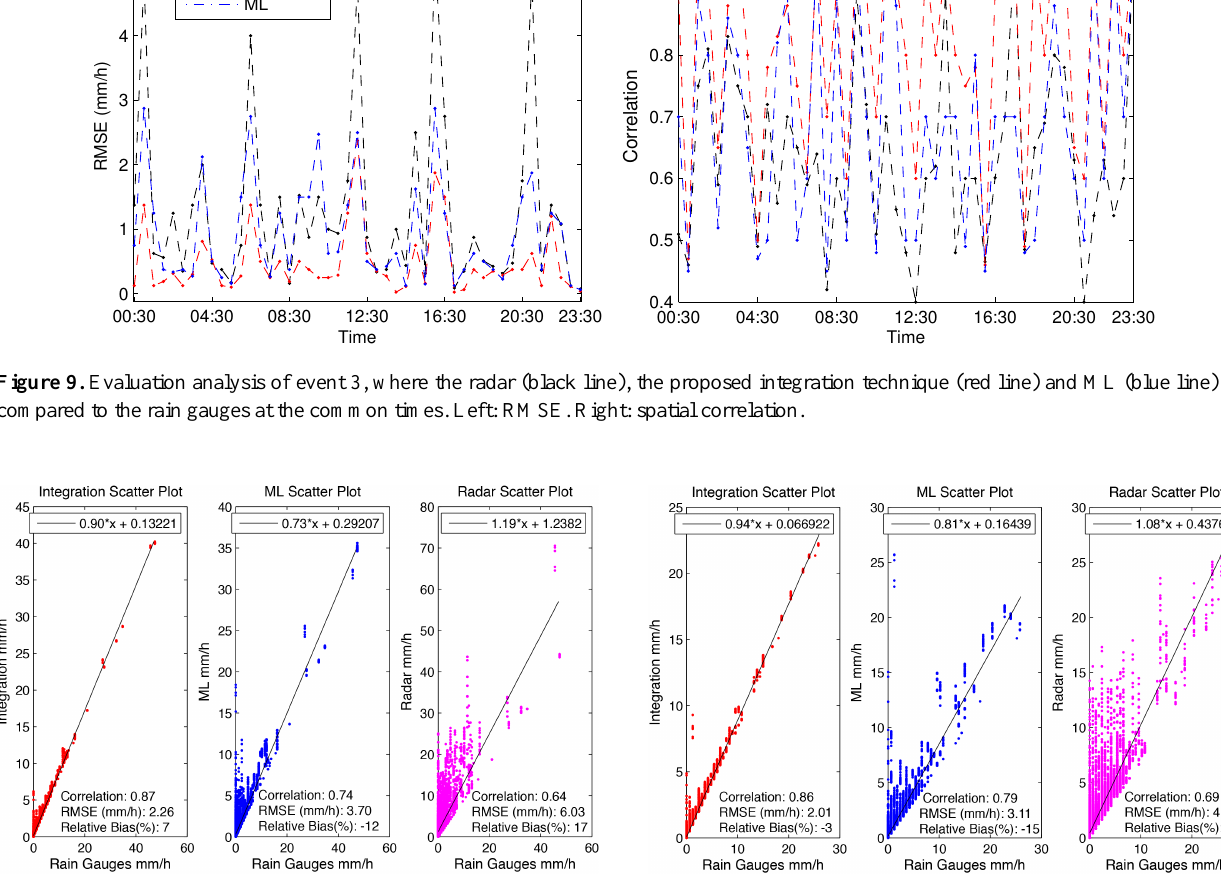
Figure 11. Rain rate scatter plots and performance evaluations of the integration (left), ML (middle) and radar (right) with respect to all the available rain gauges for event